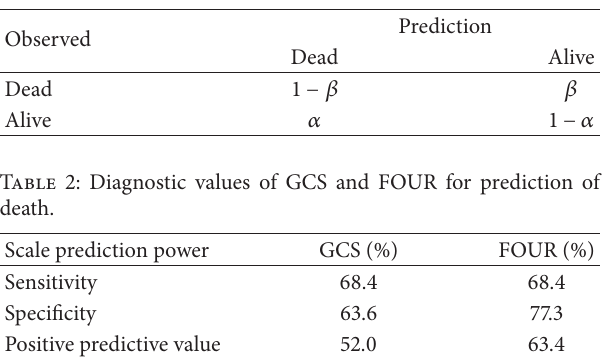
Table 1: Youden index (𝐽 = 1 − (𝛼 + 𝛽)) for explaining reveals and results interpretation.